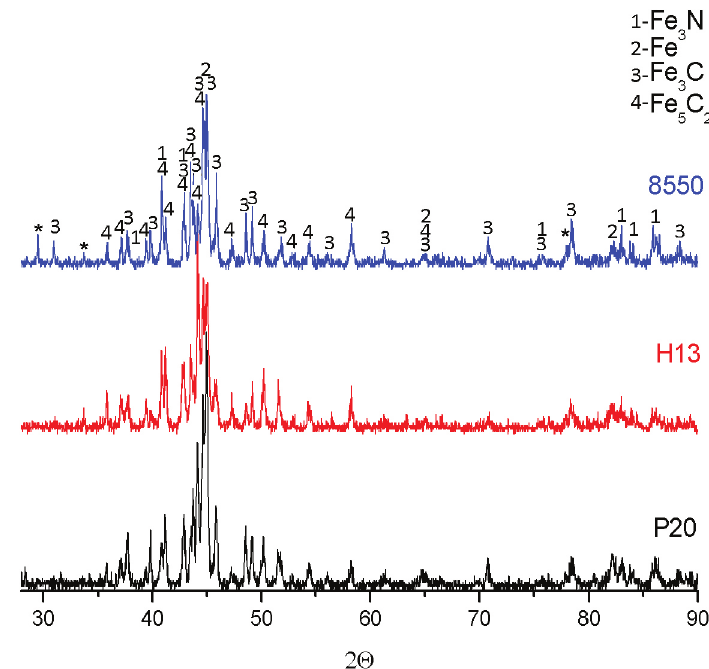
Figure 9. X-Ray diffraction obtained to the samples of solid nitriding treatment